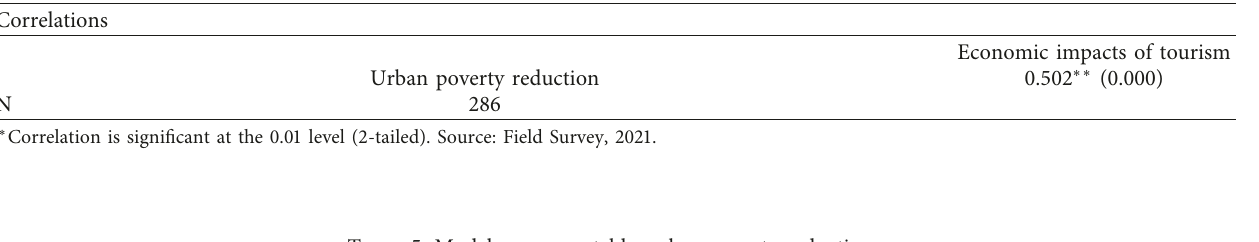
Table 5: Model summary table: urban poverty reduction.